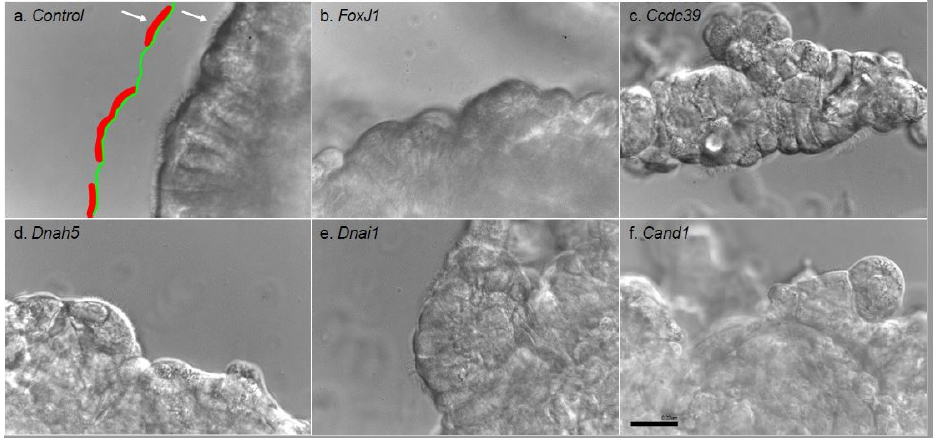
Figure 2. Quantification of ciliation using ImageJ program. Video clips are opened as a single still frame in ImageJ and the circumference of the surface of spheroids that could ciliate is outlined ( a —red, as well as the actual circumference that achieved ciliogenesis ( a —green). Dividing the reciliated surface by the total surface provides percent ciliation. Panels b-f show ciliation in suspension after siRNA knockdown of Foxj1 ( b ), Ccdc39 ( c ), Dnah5 ( d ), Dnai1 ( e ), and Cand1 ( f ). Scale bar represents 100 µ